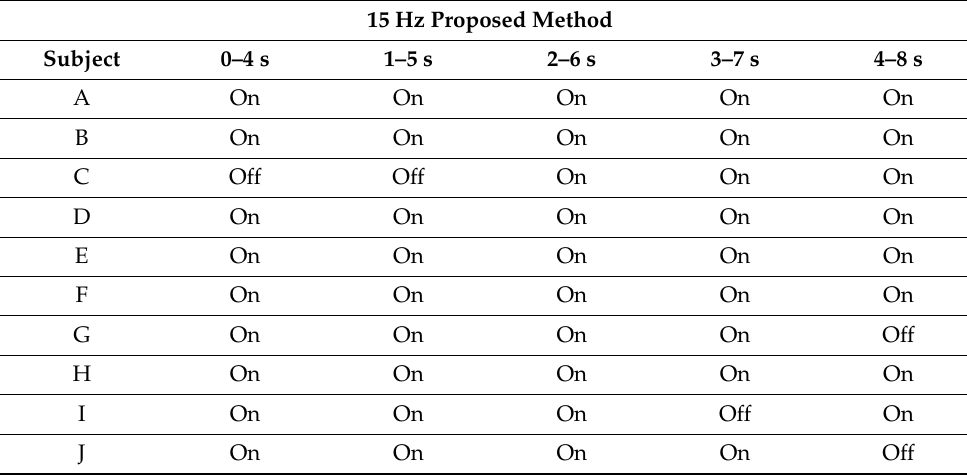
Table 2. The traditional method has five signals in the 15 Hz brainwave